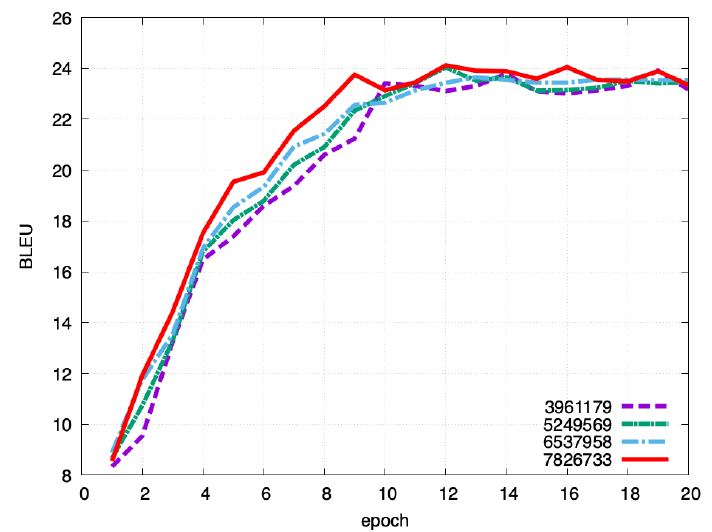
Figure 12. Effect of data size changes for English–Chinese